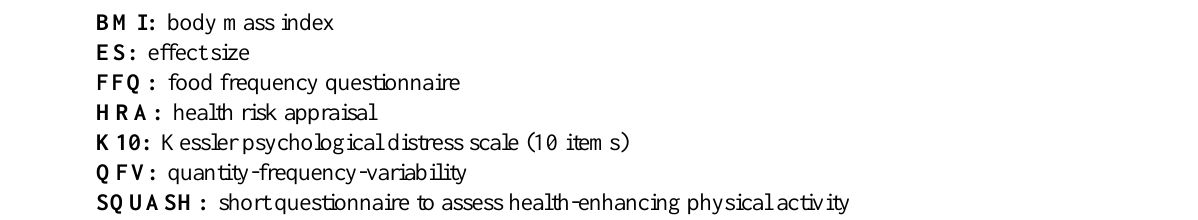
SQUASH: short questionnaire to assess health-enhancing physical